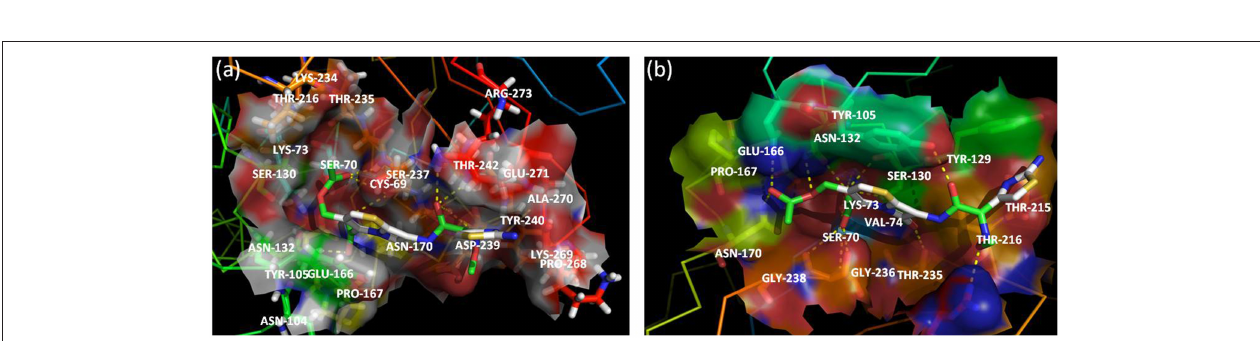
FIGURE 4 | Key polar interactions observed between enzyme CTX-M-152 (A) or CTX-M-9 (B) and Cefotaxime. The broken lines represent hydrogen bonds and interacting amino acid residues are labeled. The cefotaxime is shown in stick form; oxygen atoms are red, nitrogen atoms in blue, carbon atoms white, and sulfur atoms in yellow.